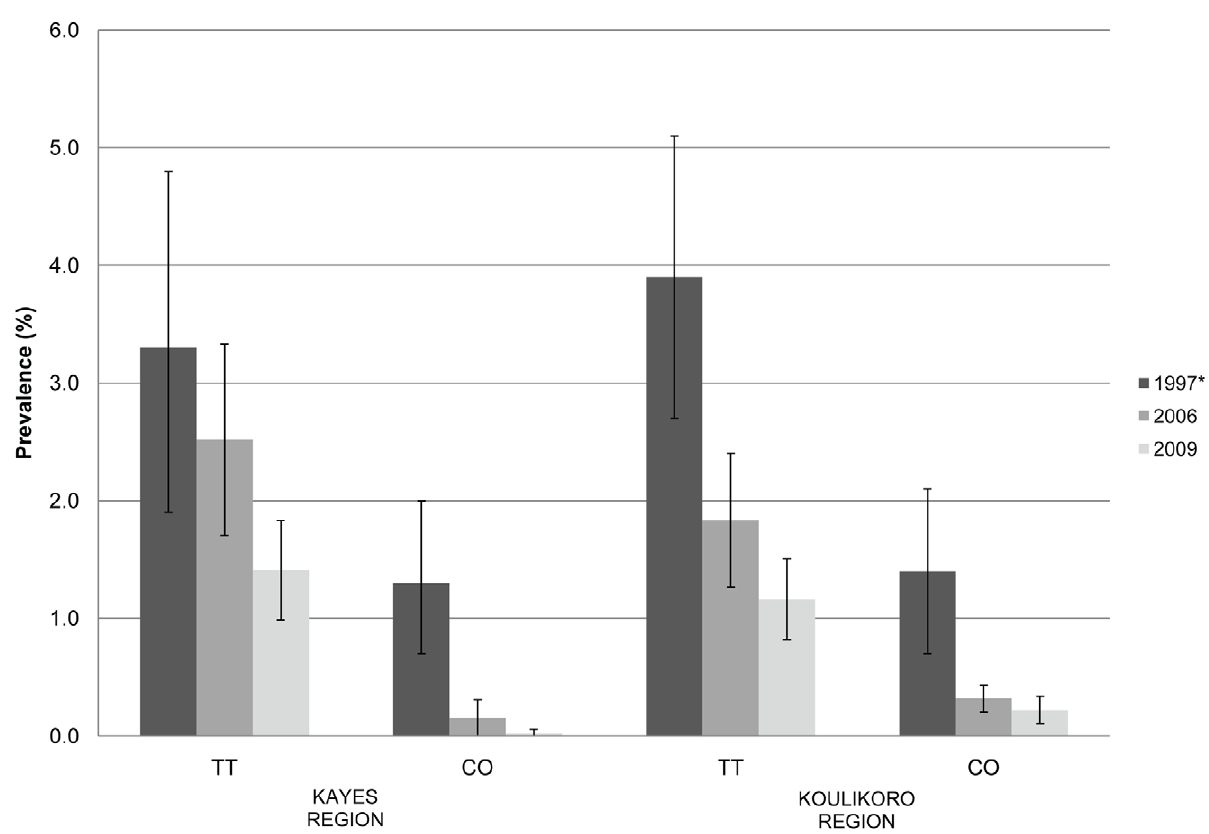
Figure 2. Prevalence of blinding trachoma (TT and CO) among women 15 years and older in Kayes and Koulikoro 1997*, 2006 and 2009. *regional estimate from Sche´mann et al 1998.